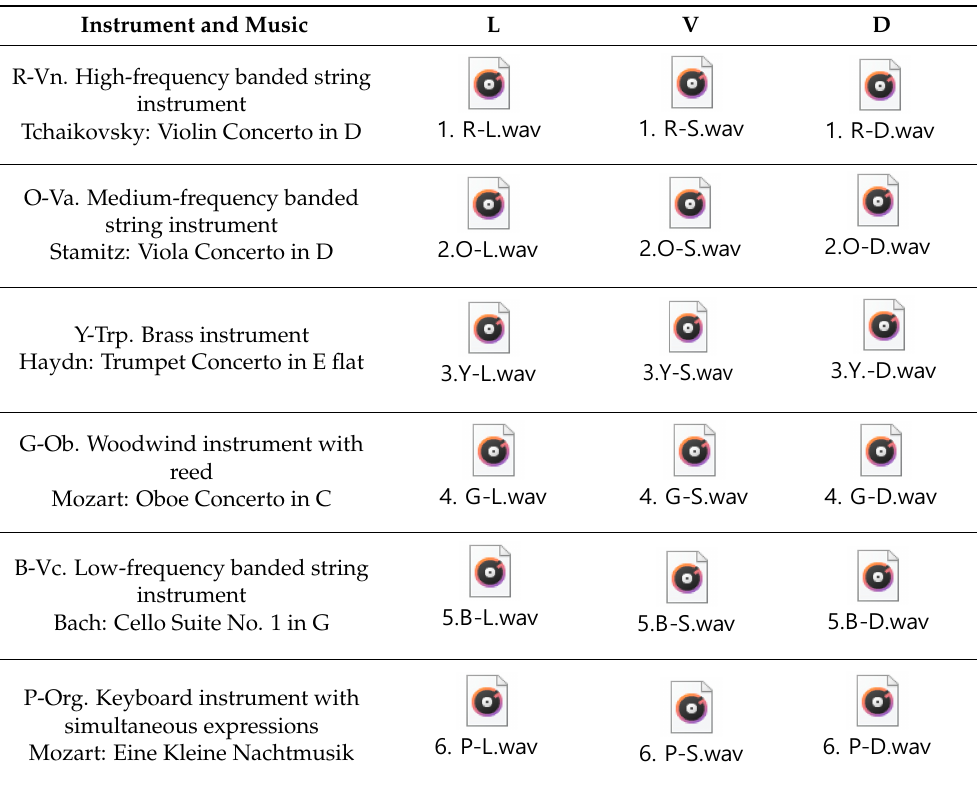
Table 2. Sound coding color [26] (the sound files developed in this research are provided separately as a supplement material).